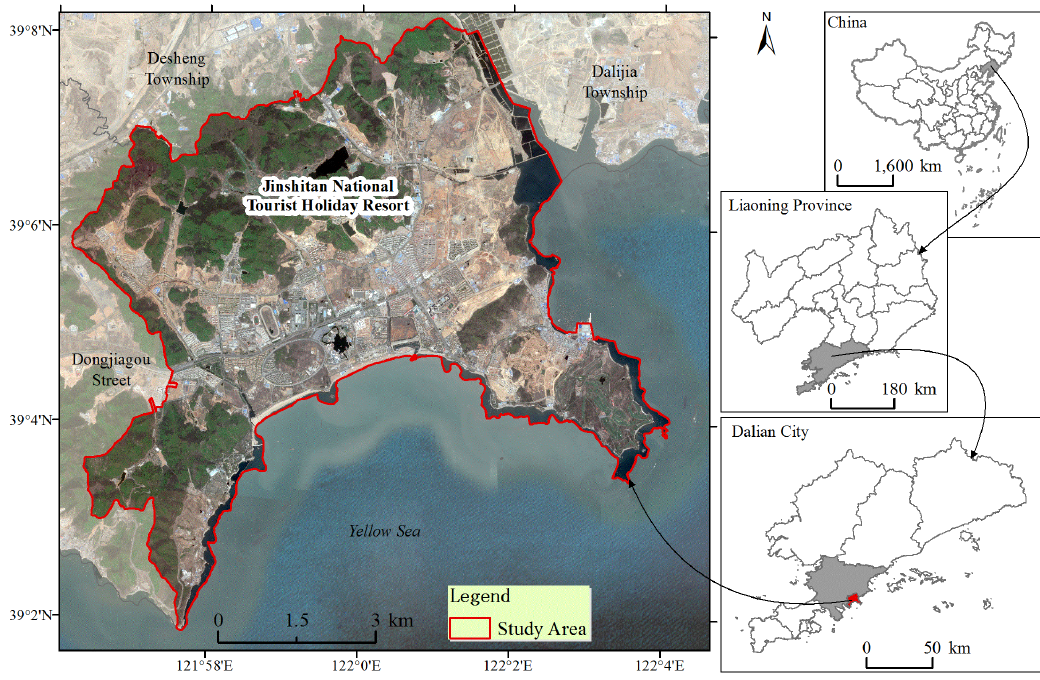
Figure 1. Location of study area, Dalian, Liaoning, China. The remote sensing image was generated based on 10 m multispectral and 2.5 m panchromatic spatial resolution SPOT5 image.